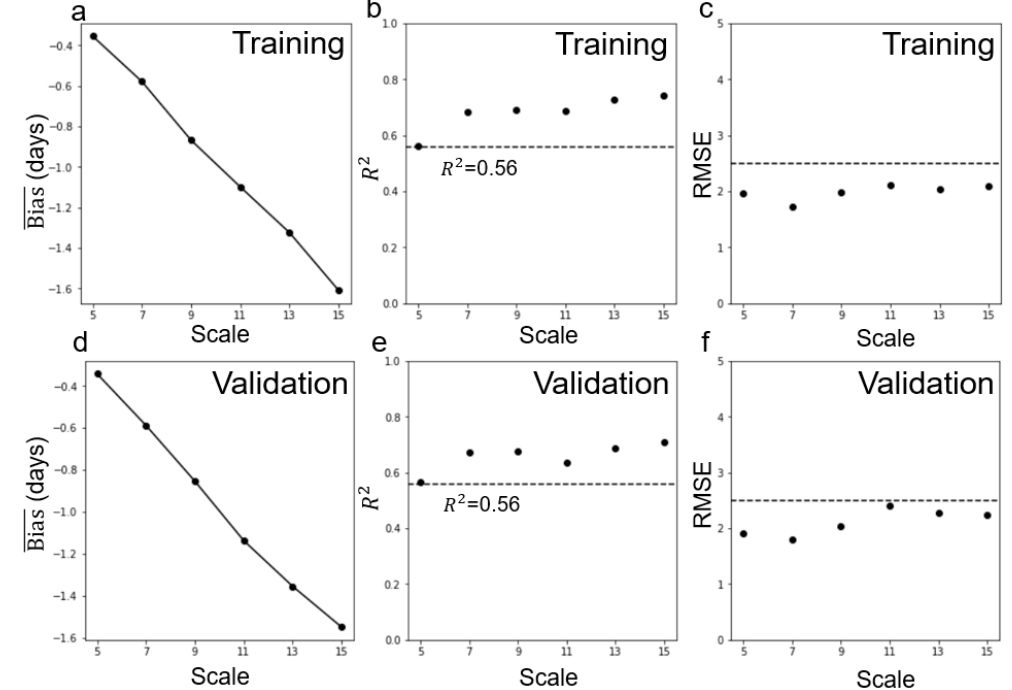
Figure 9. The same as Figure 8, but for the Landsat-MODIS fused EVI2 data. Scale refers to the size of the aggregated window.